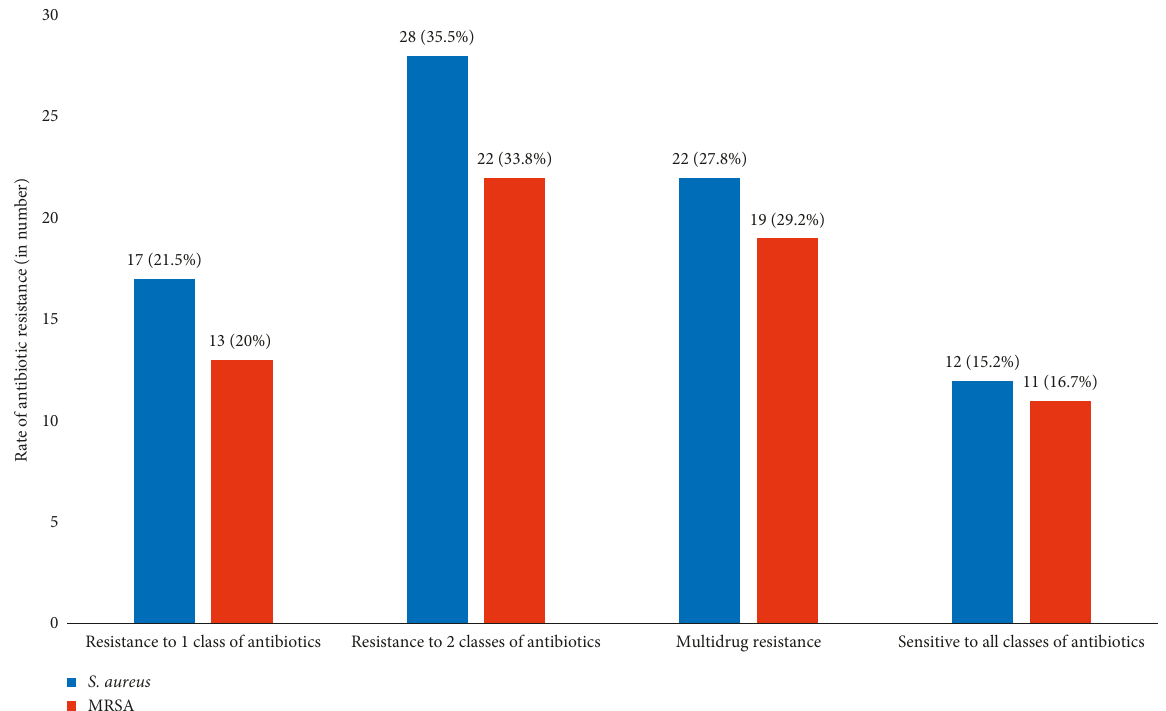
Figure 2: Antibiogram of S. aureus and MRSA isolated from patients with wound infection attending Arba Minch Hospital, Arba Minch, South Ethiopia, April to June